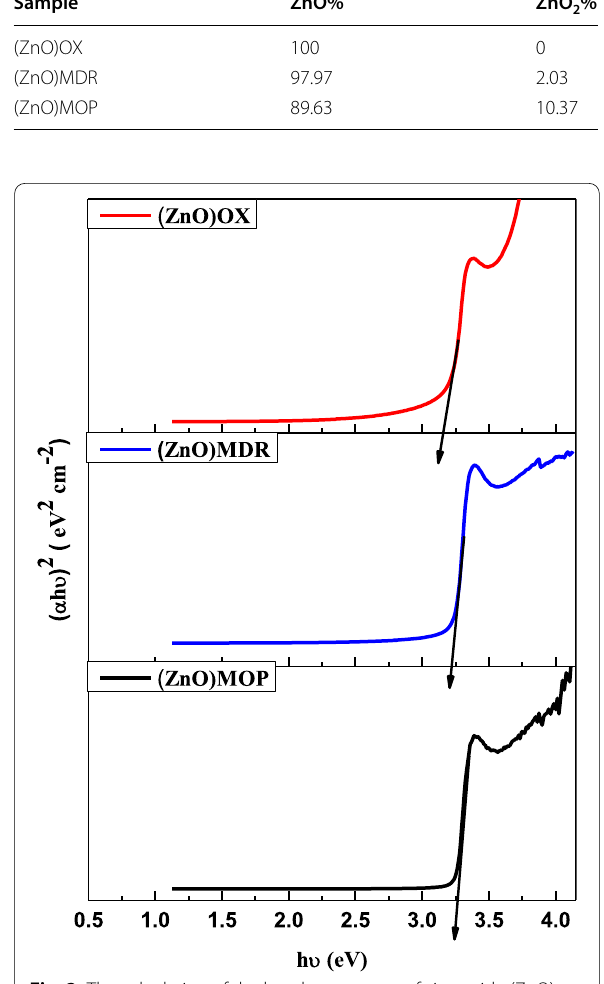
Figure 1b represents the Fourier transform infrared spectroscopy (FTIR) spectra of ZnO NPs obtained from three preparation methods, such as (ZnO)OX, (ZnO) MDR, and (ZnO)MOP. These FTIR spectra revealed a peak located at ~ 600 cm − 1 that attributed to ZnO bonds, and the FTIR peak located at ~ 870 cm − 1 was attributed to Zn–OH bonds (Moniri et al. 2017). It is clear from Fig. 2b that Zn–O bonds exist in all ZnO NP samples, and Zn–OH bonds are present in the ZnO sample only.